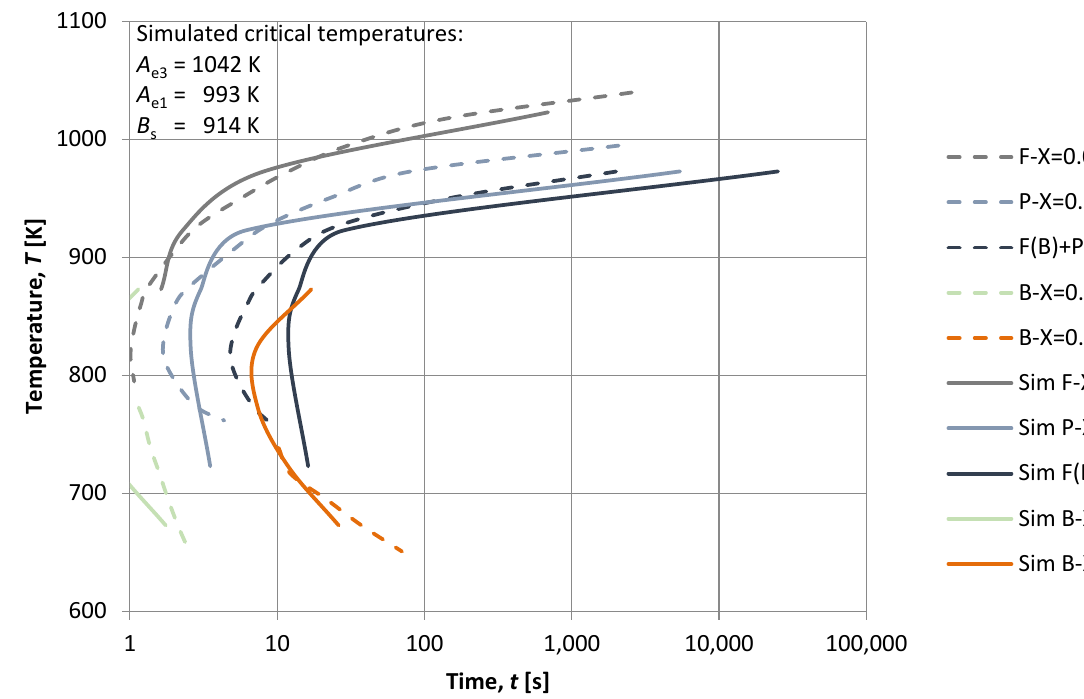
Figure 4. IT diagram of steel Ck45.